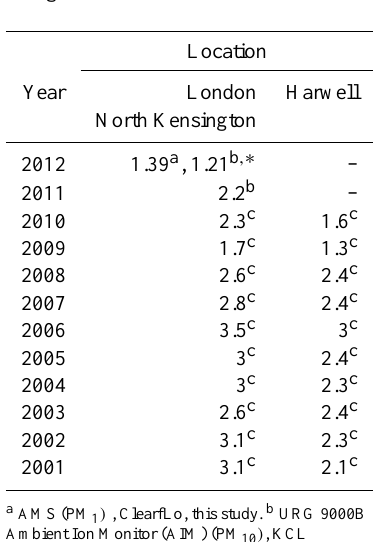
Table 1. Average annual sulphate concentrations (in µgm − 3 ) from two UK locations measured between 2001 and 2012 as part of the AURN and Particulates networks. London North Kensington is an urban background monitoring site and Harwell is a rural back- ground monitoring